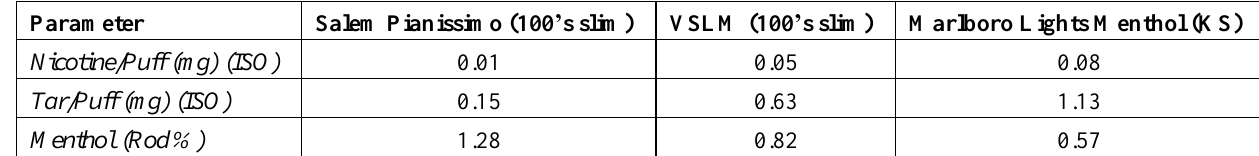
Table 3. Reverse engineering cigarette parameters of japanese cigarettes—1999 British American tobacco (data from